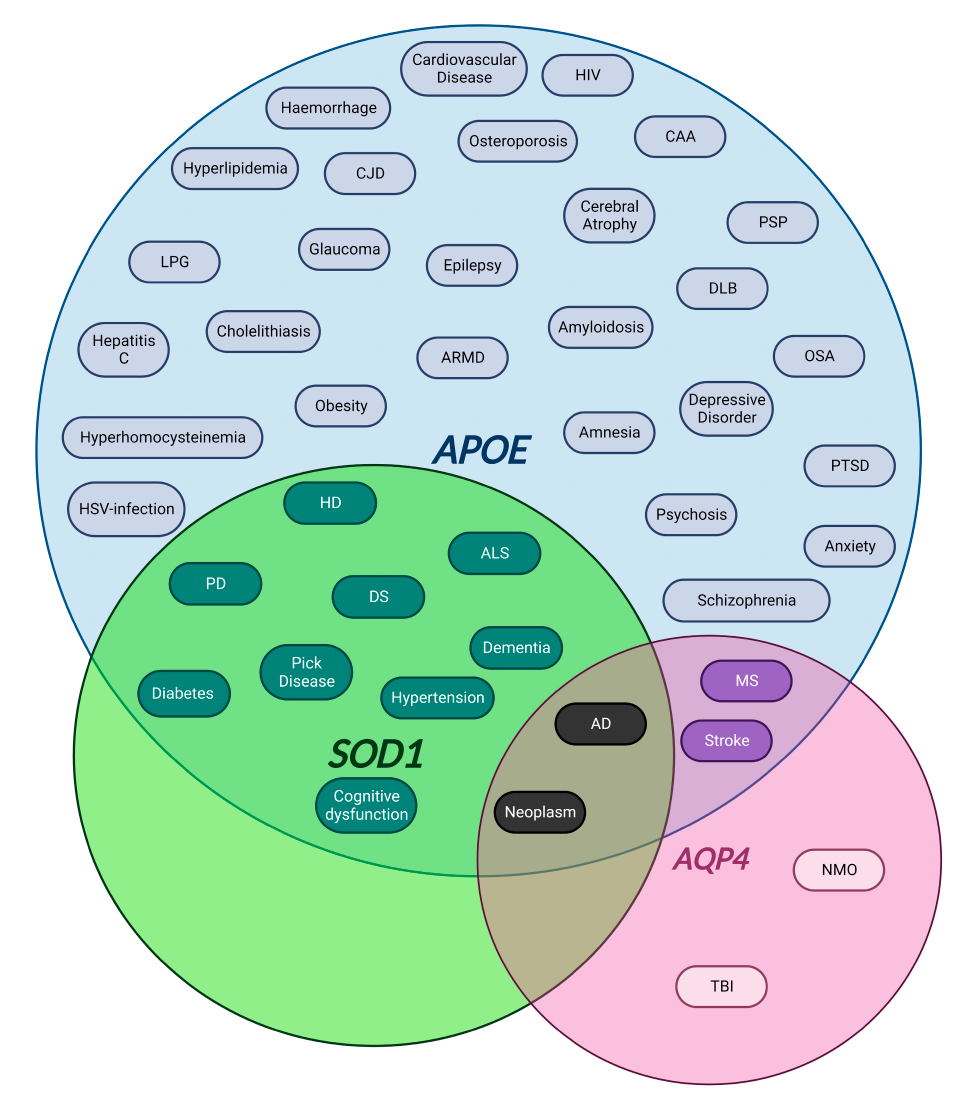
Figure 1. APOE, SOD1 and AQP4 genes are involved in multiple brain disorders and other patholo- gies. To create the Venn Diagram, diseases reported in ten or more research studies were selected. All the data related to APOE, SOD1, AQP4 and their variants associated with human diseases were explored in the platform DisGeNET. Acronyms used: Age-related Macular Degeneration (ARMD), Alzheimer’s Disease (AD), Amyotrophic Lateral Sclerosis (ALS), Congenital Aural Atresia (CAA), Creutzfeldt–Jakob disease (CJD), Down Syndrome (DS), Herpes Simplex Virus Infections (HSV-infection), Huntington Disease (HD), Traumatic Brain Injury (TBI), Lewy Body Disease (DLB), Lipoprotein Glomerulopathy (LPG), Multiple Sclerosis (MS), Neuromyelitis Optica (NMO), Parkin- son’s Disease (PD), Post-Traumatic Stress Disorder (PTSD), Progressive Supranuclear Palsy (PSP), and Obstructive Sleep Apnoea